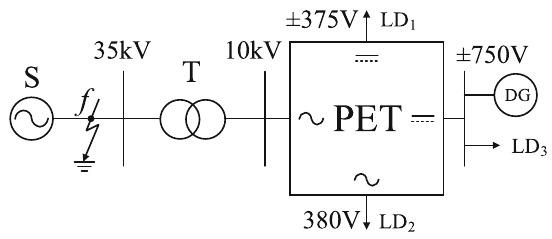
Fig. 9 simulation system model of PET